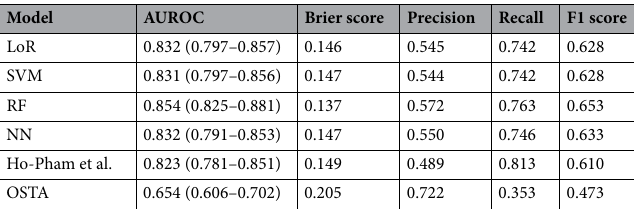
Table 5. The performances of the models in the first scenario.